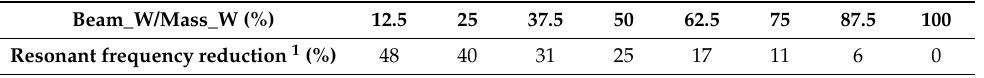
Table 1. Summary of the effect of the Beam_W/Mass_W ratio on the resonant